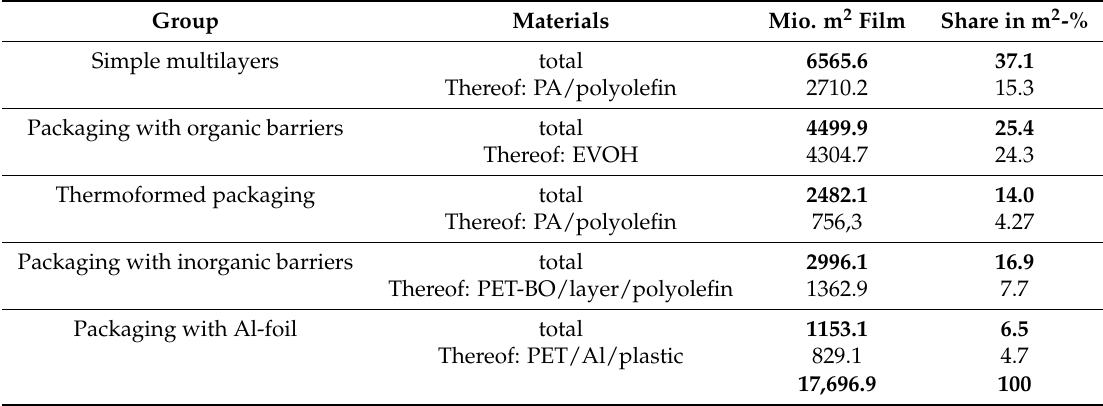
Table 2. Quantities of the five flexible plastic-based multilayer packaging categories and, in each case, the most important example is given in millions (mio.) m 2 and in percent m 2 . The percentage refers to the sum of packaging used in these categories in Europe in 2016 [13]. PET-BO is the abbreviation for biaxially-oriented PET. Group Materials Simple multilayers total Packaging with organic barriers total Thereof: EVOH Thermoformed